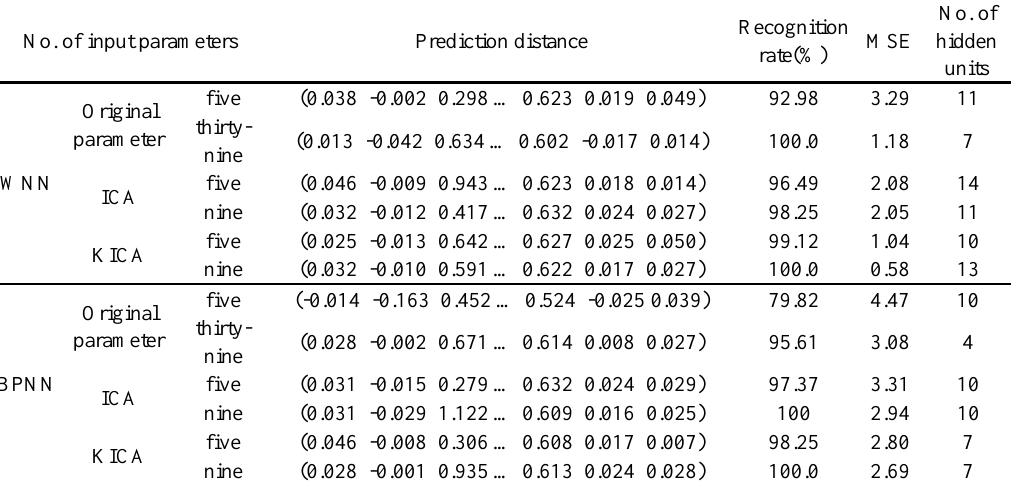
Table 3. Testing results.